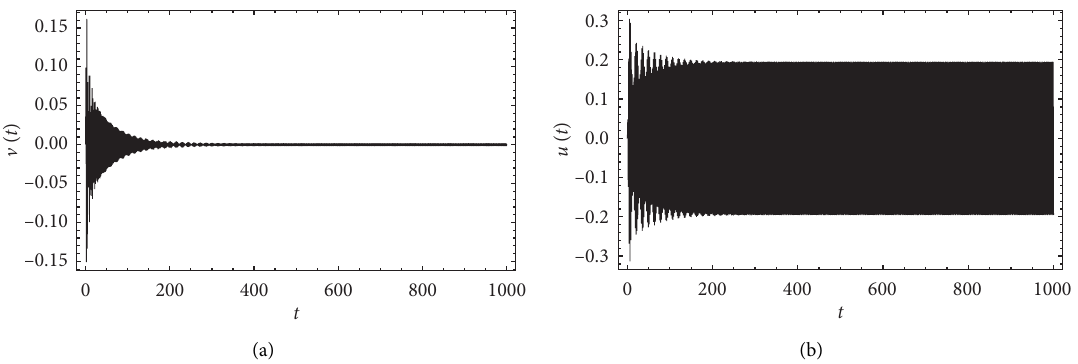
Time history of the controlled system